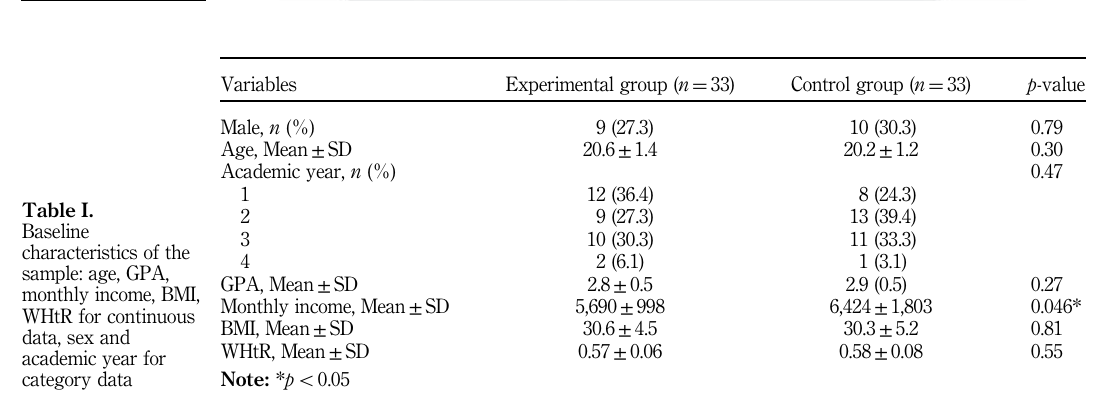
Figure 1. Demonstrates the research activities of the experimental and